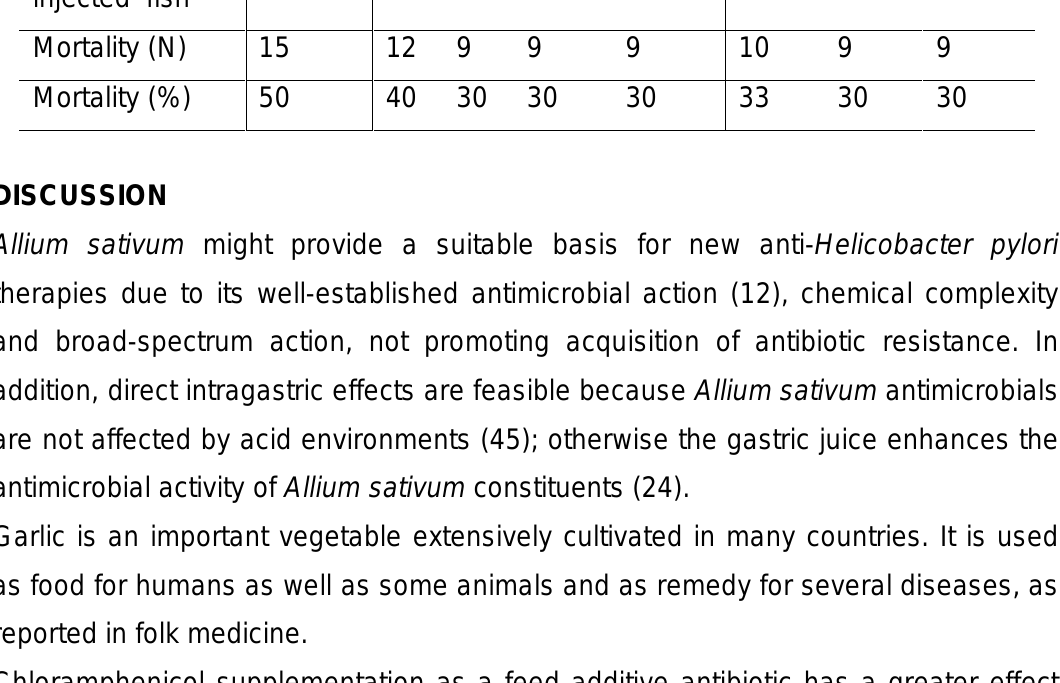
Table 11: Challenge test of A. hydrophila injected by intraperitoneal route and mortality rate among O. niloticus treated with Allium sativum and chloramphenicol. Control Allium sativum levels Chloramphenicol levels (g/kg diet) (mg/kg diet) Treatment (0) 10 20 30 40 15 30 45 Number of 30 30 30 30 30 injected fish Mortality (N) 15 12 9 9 9 9 9 Mortality (%) 50 40 30 30 30 33 30